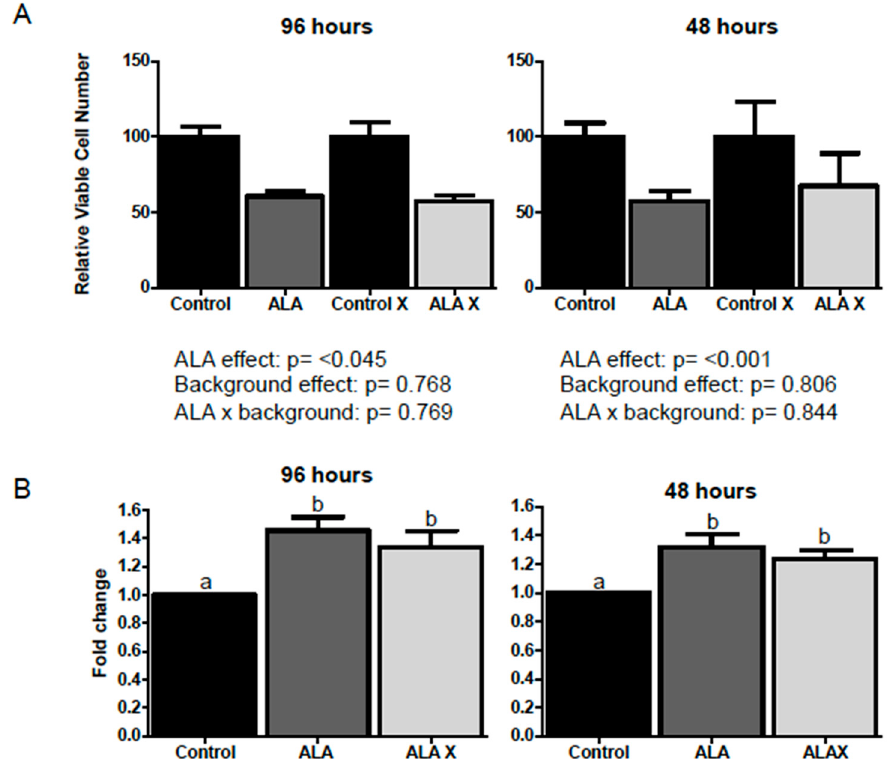
Figure A1. ( A ) Effect of ALA alone or in combination with background fatty acids on cell viability. 100 μ M ALA alone or combined with 40 μ M each oleic acid (OA) and linoleic acid (LA) both significantly reduced the cell viability of MCF-7 cells following 48 and 96 h treatment. A significant ALA effect (48 h p ≤ 0.05; 96 h p ≤ 0.001), but no background fatty acid effect was observed. There was no interaction between ALA and background fatty acids at either time point. Cell viability is expressed as a % of the control viable cell number; ( B ) Effect of ALA alone or in combination with background fatty acids on miR-21 expression after 24, 48 and 96 h treatment. This same treatment significantly increased miR-21 expression after the same treatment times. ALA alone and combined with background fatty acids significantly increased the expression of miR-21 at 48 h (fold change = 20–30% increase; p ≤ 0.01) and 96 h (fold change = 30–40%; p ≤ 0.001) when compared to the control (Figure 1). Since background fatty acids did not influence ALA effect, additional studies were conducted in the presence of background fatty acids to render our findings more physiological. Data were normalized to the endogenous control U6 and fold change was calculated with the 2 −ΔΔ C t method [19]. Bars with different letters (a,b) are significantly different from one another ( p < 0.05). X = background fatty acids—oleic acid, linoleic acid.